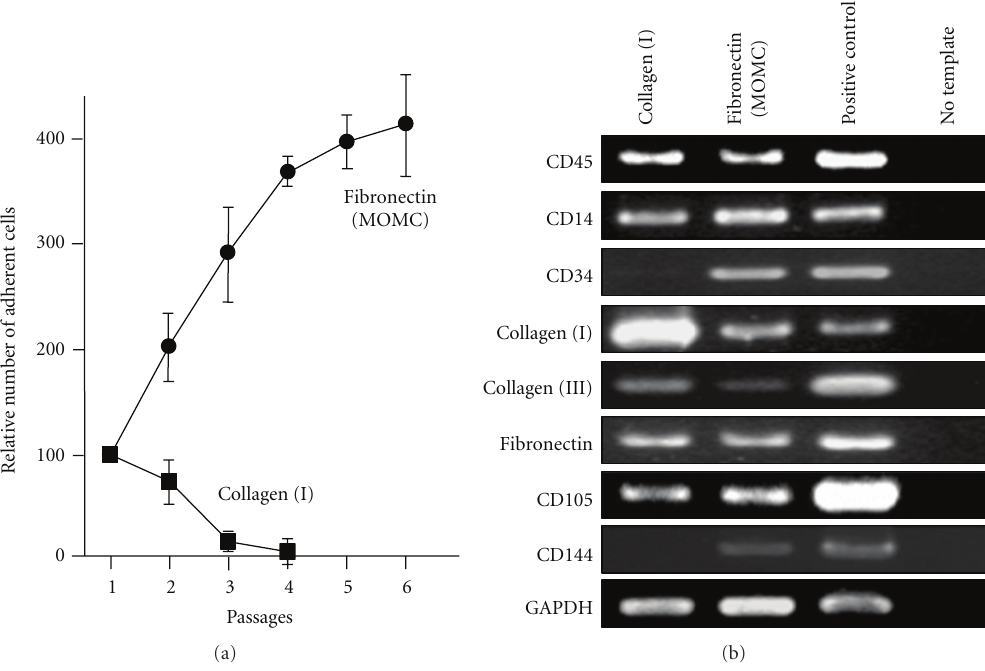
Figure 2: Proliferative capacity and gene expression profiles of adherent cells obtained in the MOMC generation cultures on fibronectin or collagen (I). (a) PBMCs (2 × 10 6 ) were cultured on 24-well plastic plates coated with fibronectin (Sigma) or collagen (I). The medium containing floating cells was exchanged with fresh medium every 3 days. At day 7, all adherent cells were detached, counted, and replated on plates coated with fibronectin (Sigma) or collagen (I). Results are expressed as proportion of the number of adherent cells recovered at each passage to the number of adherent cells recovered at the first passage. The mean and standard deviation of 5 independent experiments are shown. (b) Adherent cells recovered were subjected to reverse transcription and semi-quantitative PCR for evaluation of mRNA expression. Positive controls for the specific amplification included pooled PBMCs for CD14, CD45, and GAPDH; cultured human umbilical vein endothelial cells for CD34, CD105, and CD144; cultured skin fibroblasts for collagen (I), collagen (III), and fibronectin. The results are representative of 4 independent